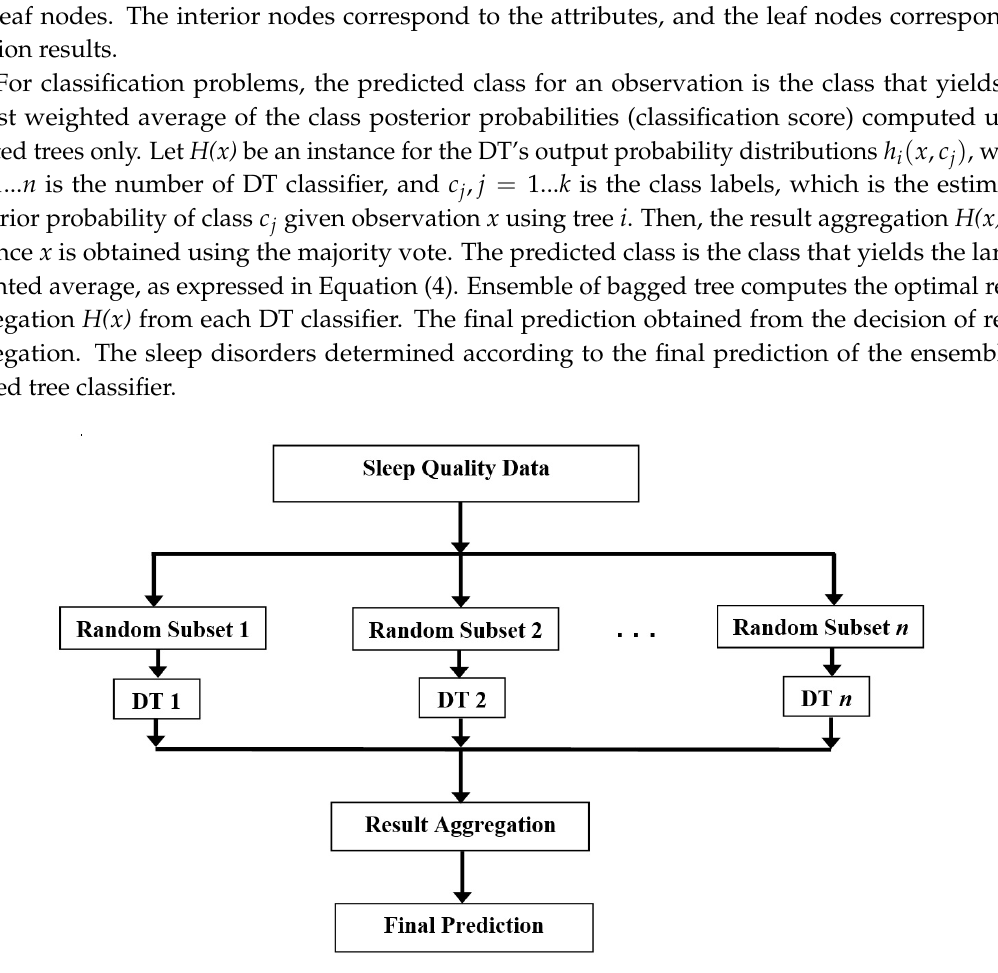
Figure 5. General scheme of ensemble of bagged tree